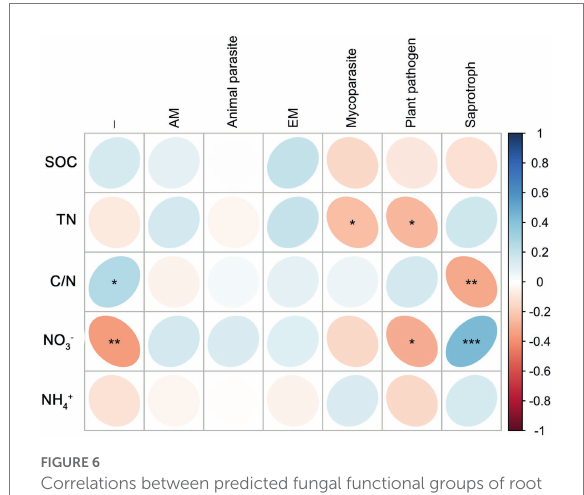
FIGURE 6 Correlations between predicted fungal functional groups of root and soil organic carbon (SOC), total nitrogen (TN), C/N ratio (C/N), soil nitrate nitrogen (NO 3 − ), and ammonia nitrogen (NH 4+ ) based on Spearman’s rank correlation. Significant difference were indicated as follows: * p < 0.05; ** p < 0.01; *** p < 0.001.